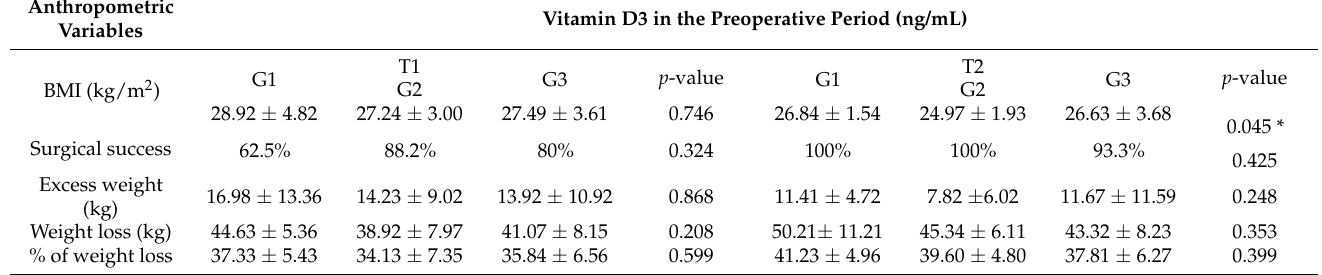
Table 3. Mean anthropometric variables in the assessed times, according to the adequacy of vitamin D3 nutritional status in the preoperative period.